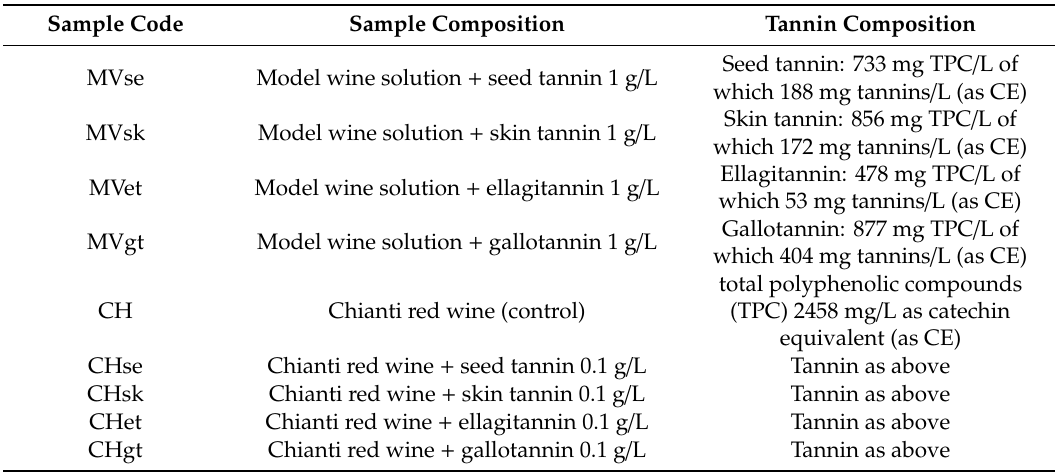
Table 3. Tannins and dosages used in the